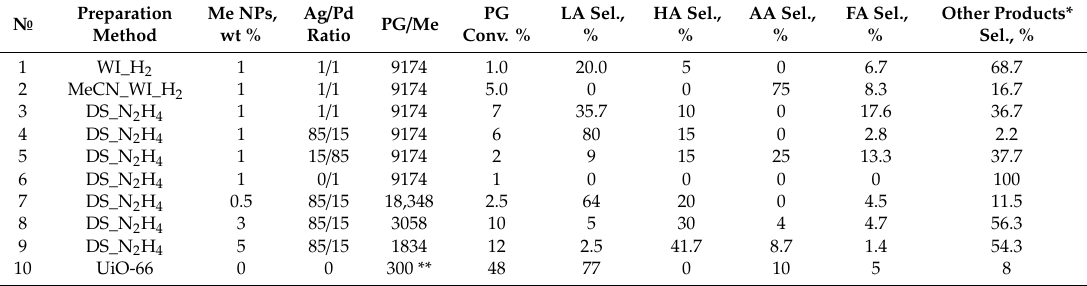
Table 4. Catalytic activity of AgPd / UiO-66 in PG oxidation (T = 90 ◦ C, P(O 2 ) = 3 bar, reaction time = 7